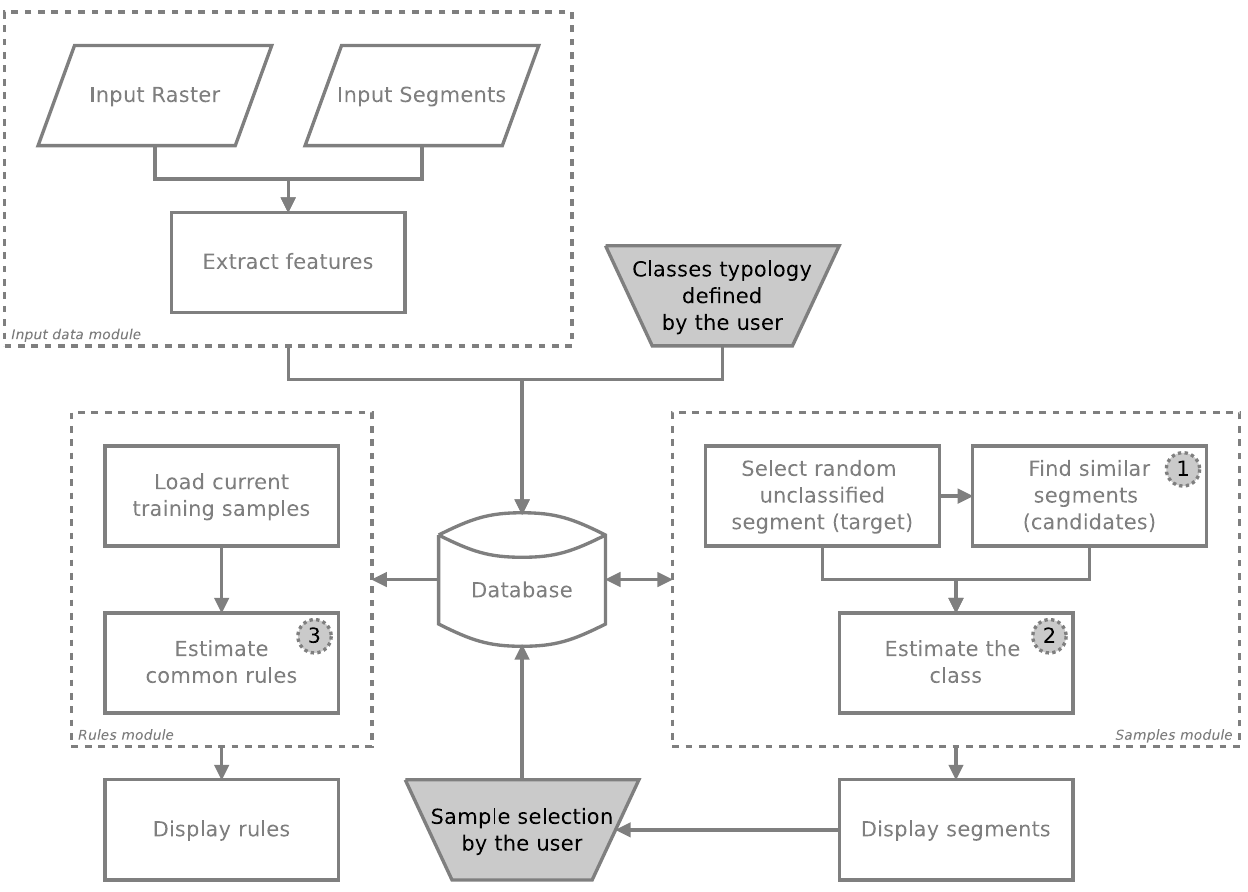
Figure 2. Main diagram for our proposal of a sample selection graphic user interfaces